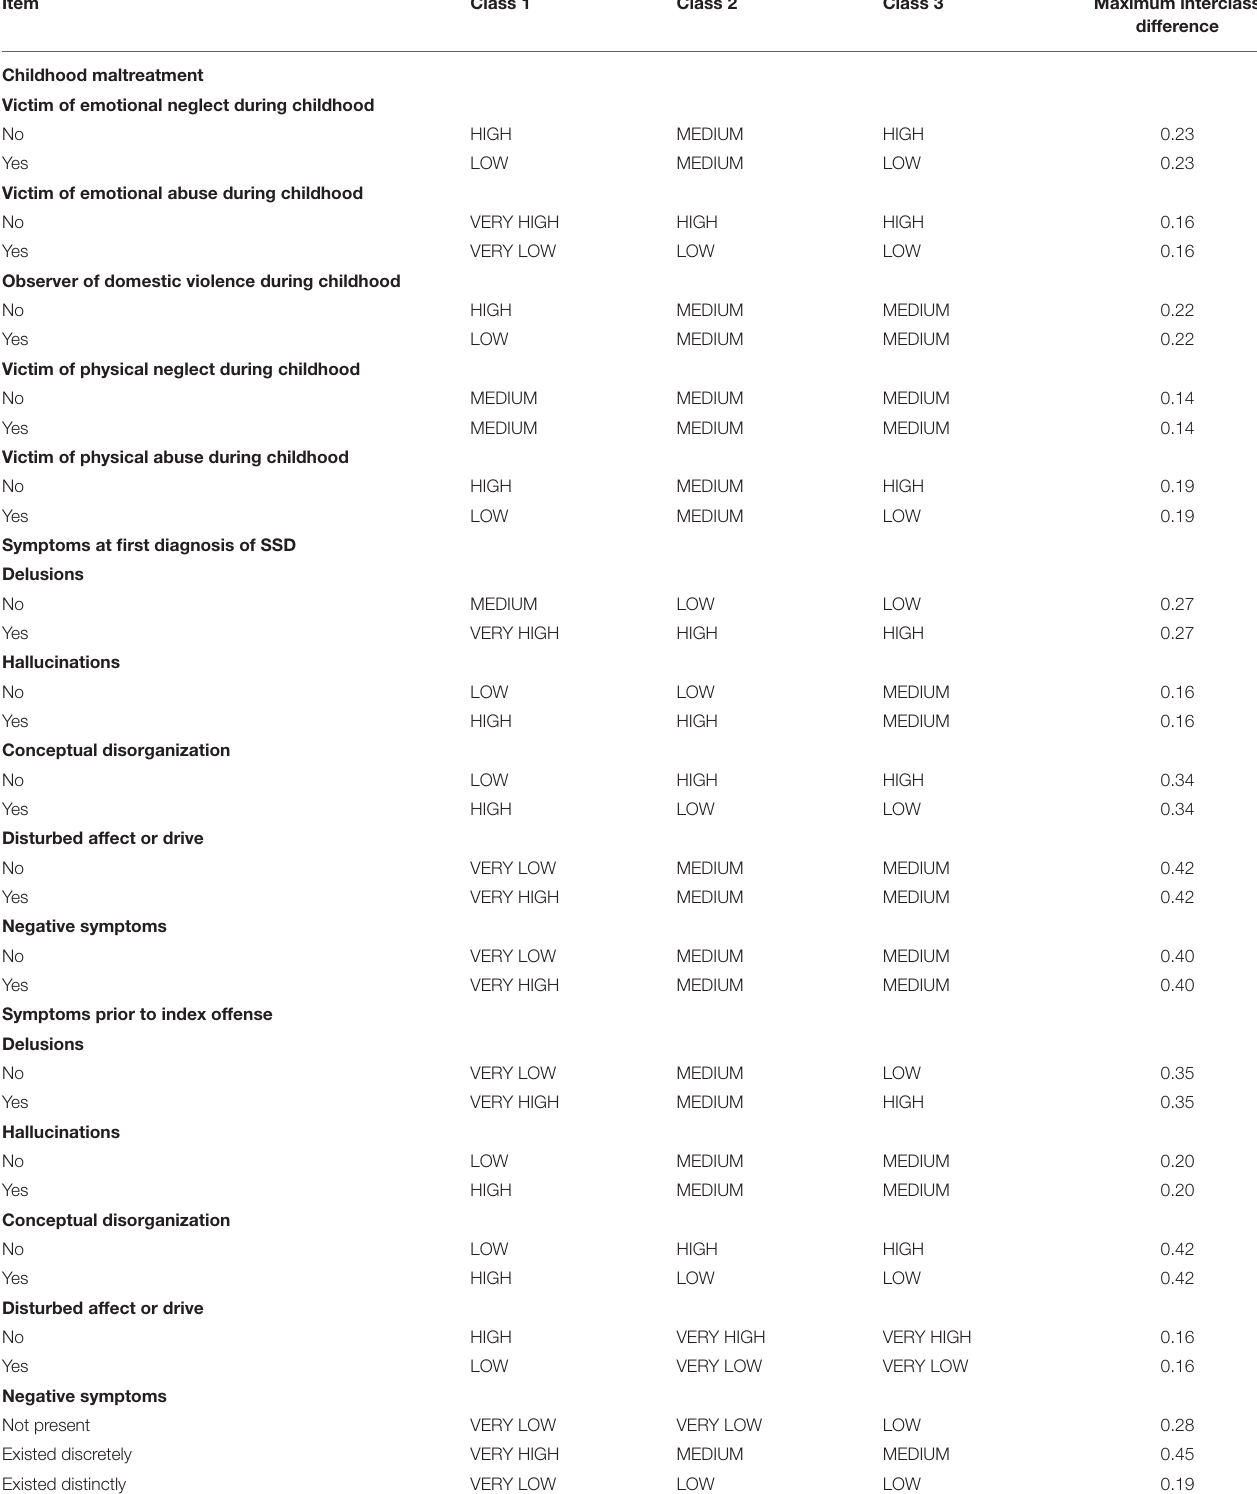
TABLE 3 | Conditional item response probabilities of a patient within a particular class to give a specific item